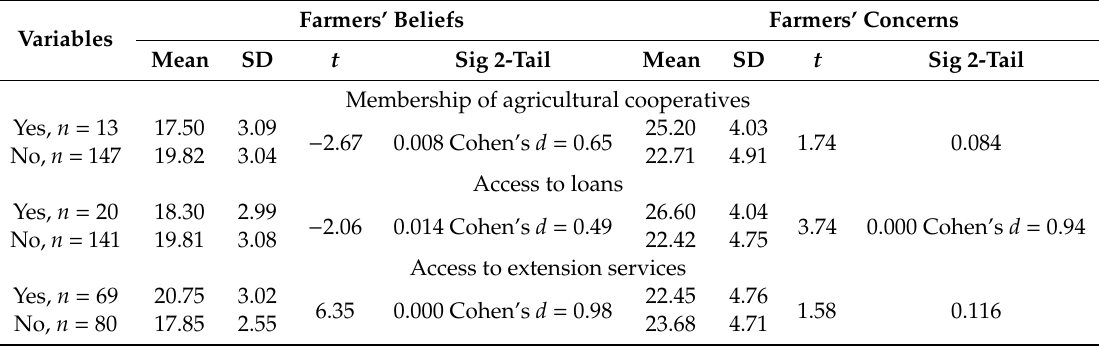
Table 6. The t -test comparison for di ff erences in farmers’ beliefs and concerns with regard to socio-economic